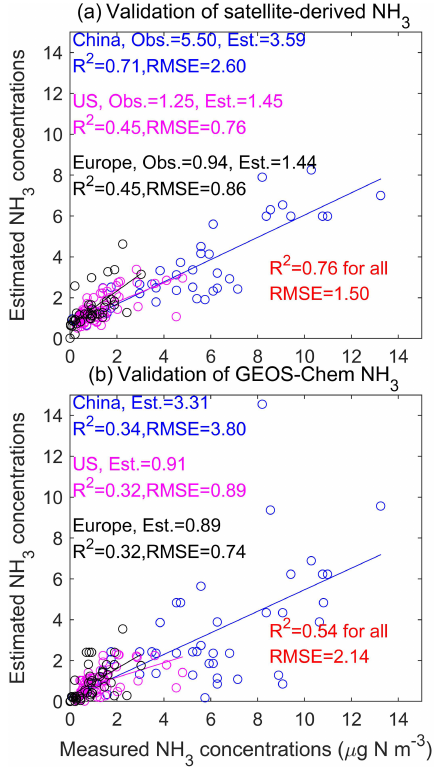
Figure 3. Comparison of satellite-derived and GEOS-Chem mod- eled surface NH 3 concentrations with measured concentrations in China, the US and